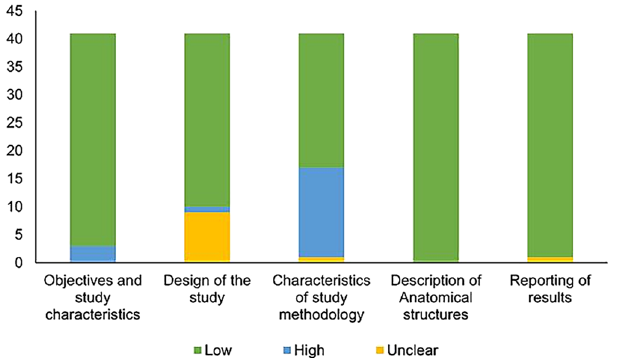
Figure 3. Quality assessment by Anatomical Quality Assessment tool (AQUA). Each study characteristics was accessed as “low,” “high,” or “unclear” risk of bias.